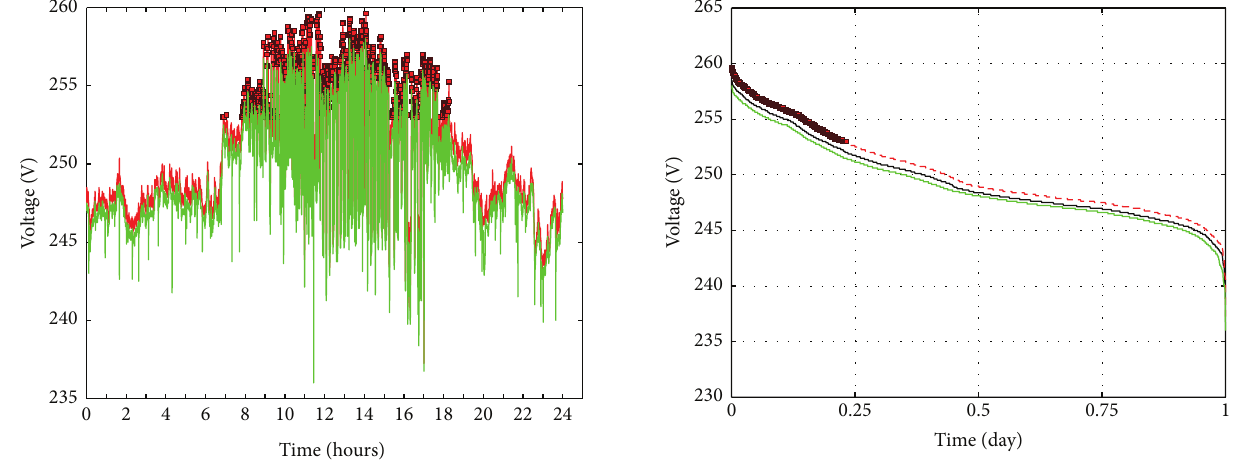
Figure 3: Voltage values registered during one day in the second facility. The green line represents the minimum voltages, the black line represents the medium voltages, and the red line represents the maximum voltages.